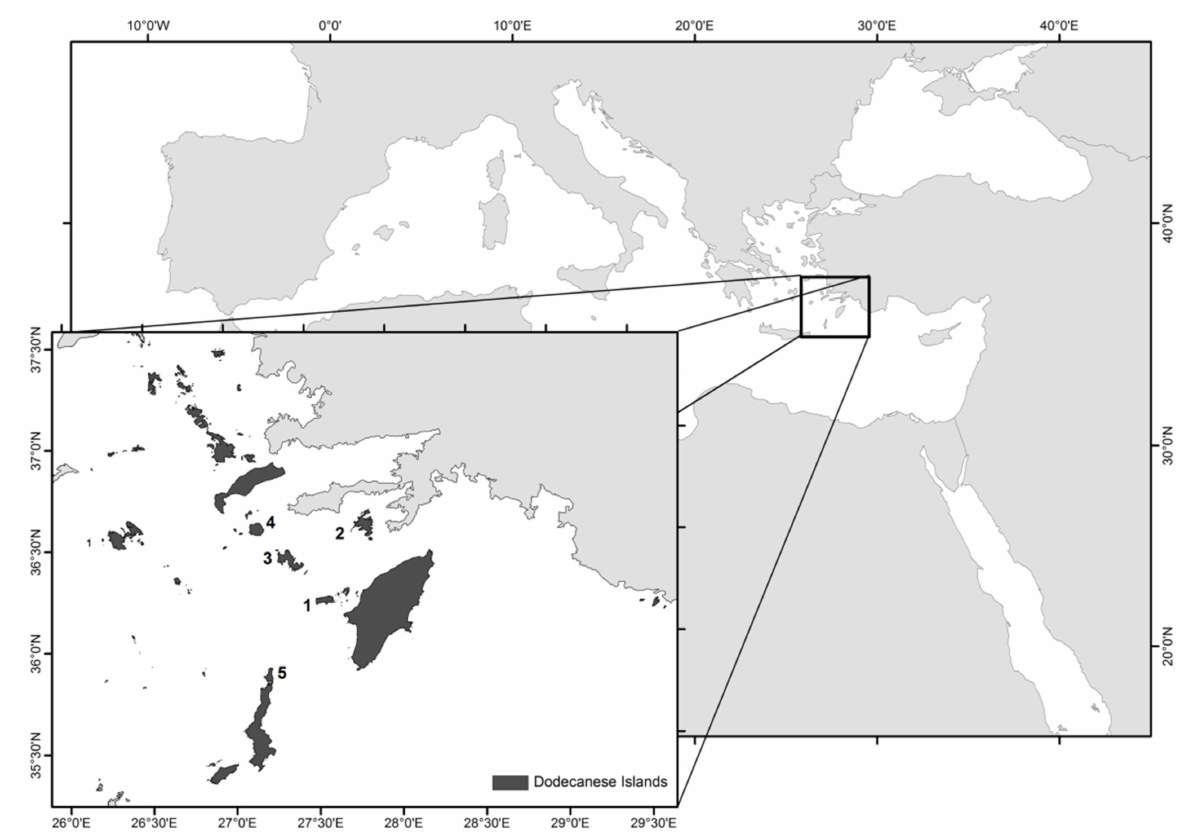
Figure 1. Study area and locations of the samplings in the southeastern Aegean Sea (i.e., 1: Halki; 2: Symi; 3: Tilos; 4: Nisyros; 5: Karpathos). Marked in dark grey is the effective fishing area